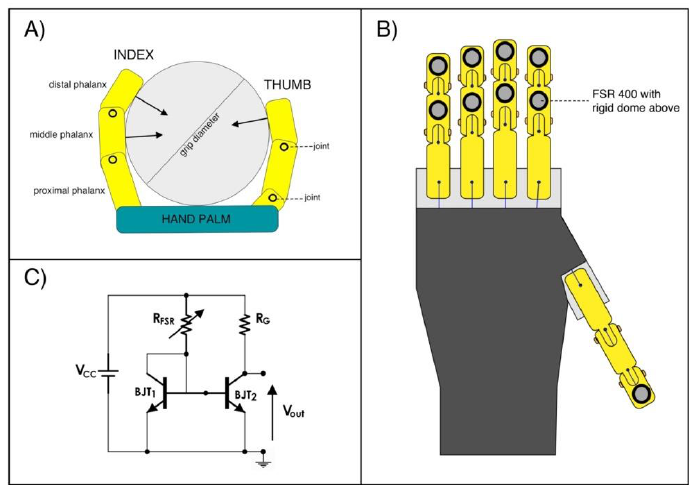
Figure 3. Force measure system for mapping the grip forces distribution between the phalanges: ( A ) Illustration from a lateral view of the “Federica” hand while grasping the cylindrical handlebar; ( B ) Illustration of the FSR-based sensors placements on the selected phalanges; ( C ) Conditioning circuit (current mirror) for one of the FSR-based sensors.